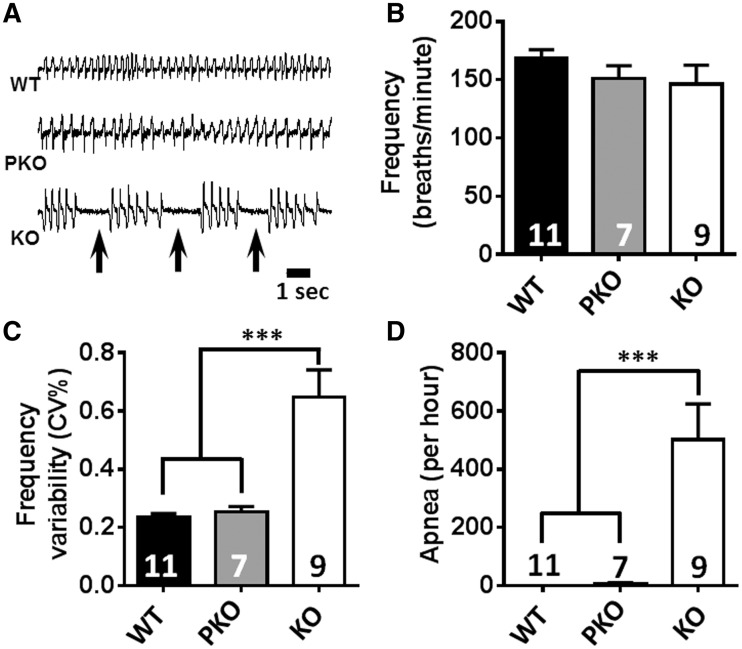
RTT-like respiratory phenotypes are absent in PKO mice. (A) Representative whole-body plethysmograph traces showing regular and erratic breathing patterns/apnoeas (arrows) in WT, stop-cre mice and in stop mice, respectively. (B) breathing frequency at rest, (C) breathing frequency variability and (D) apnoea frequency. In (B–D), data are plotted as mean values ± S.E.M. Numbers of animals per genotype are shown within each bar. Groups were compared using one-way ANOVA and Tukey’s post hoc comparisons. ***P < 0.001.